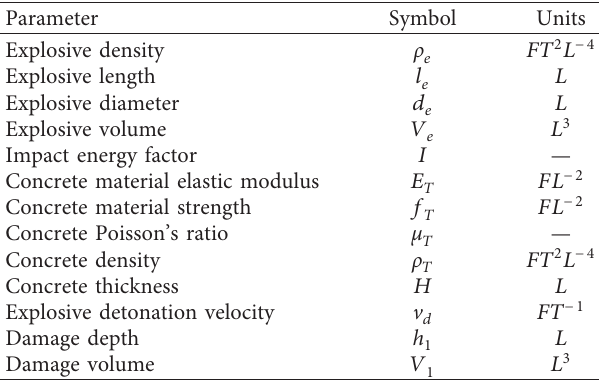
Table 3: Governing parameters for thin concrete targets experi- encing the combined effects of penetration and explosion.